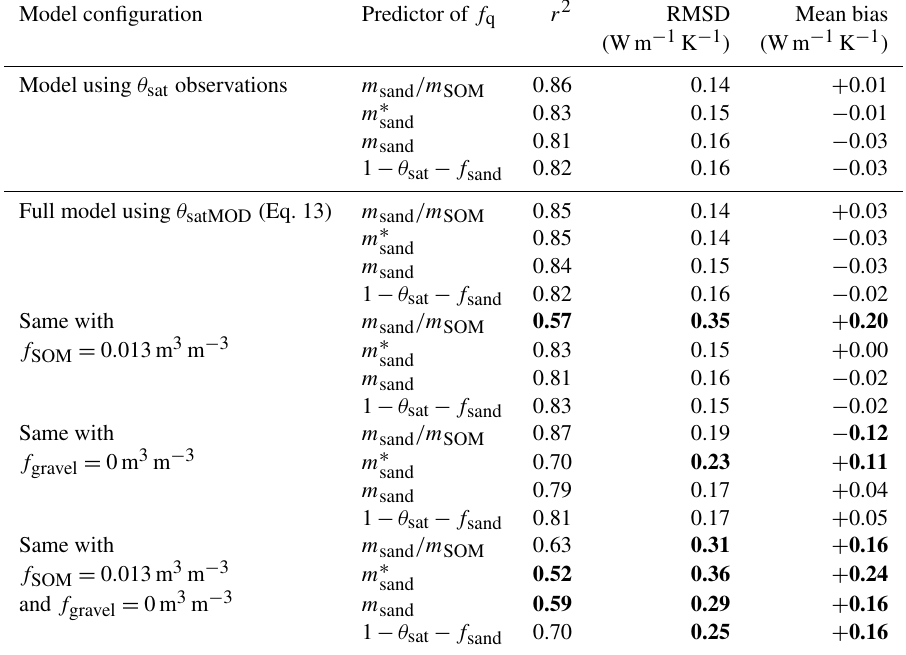
Table 5. Ability of the Eqs. (10)–(13) empirical model to estimate λ sat values for 14 soils and impact of changes in gravel and SOM volumetric content: f gravel = 0m 3 m − 3 and f SOM = 0 . 013m 3 m − 3 (the smallest f SOM value, observed for CBR). r 2 values smaller